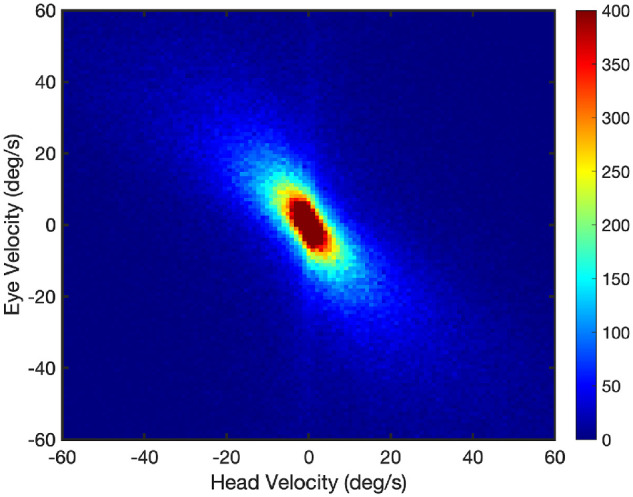
VOR demonstrated by the inverse relationship between eye and head velocities, using a bin size of 1°/s. Dark blue pixels correspond to zero frequency counts, and dark red pixels correspond to a bin count of more than 400.